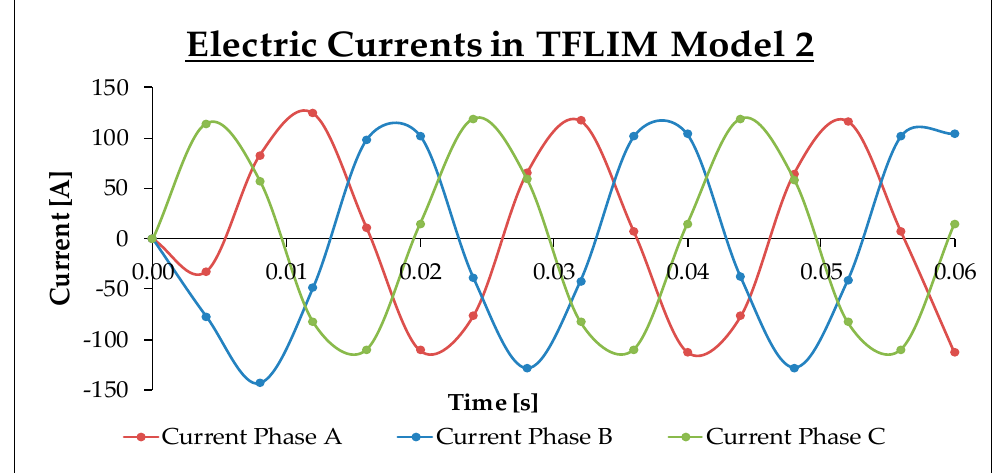
Figure 17. Electric current per phase in model 2.